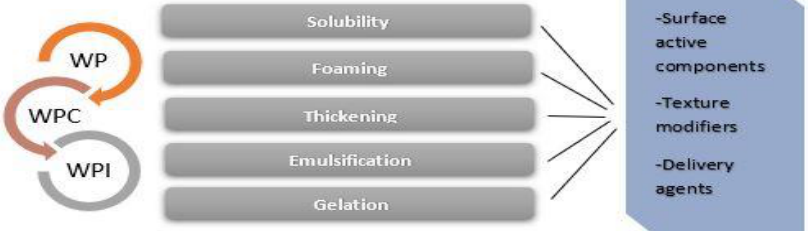
Figure 1. Technological functions of whey protein (WP), whey protein concentrate (WPC), and whey protein isolate (WPI) in food applications.